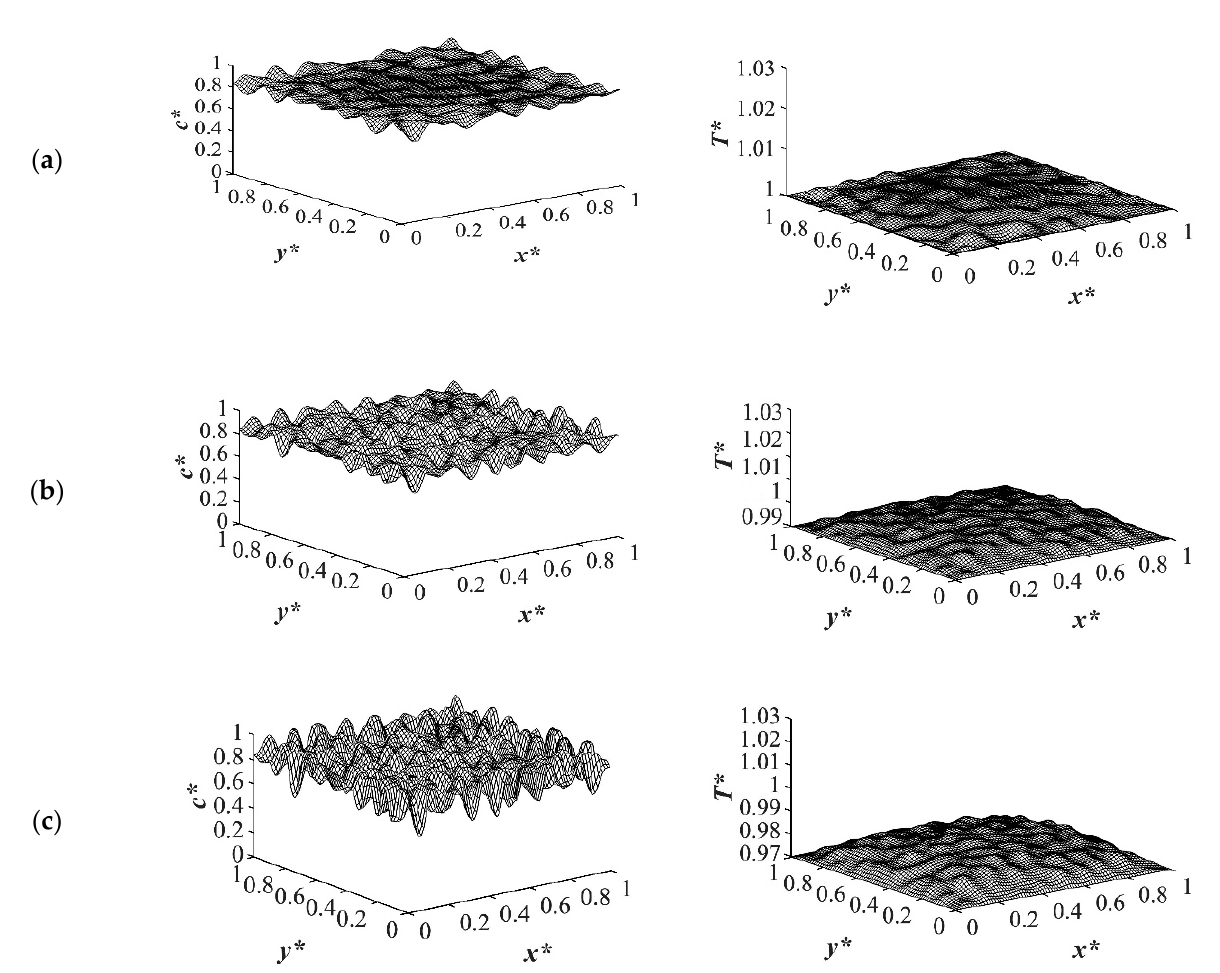
Figure 5. Spatial concentration ( left column) and temperature ( right column) profiles for the off- critical quench to c * = 0.85 at t * = 8.03 × 10 − 4 for three different quench depths of ( a ) T * q1 = 1.0, ( b ) T * q2 = 0.99 ( c ) T * q3 = 0.97 .